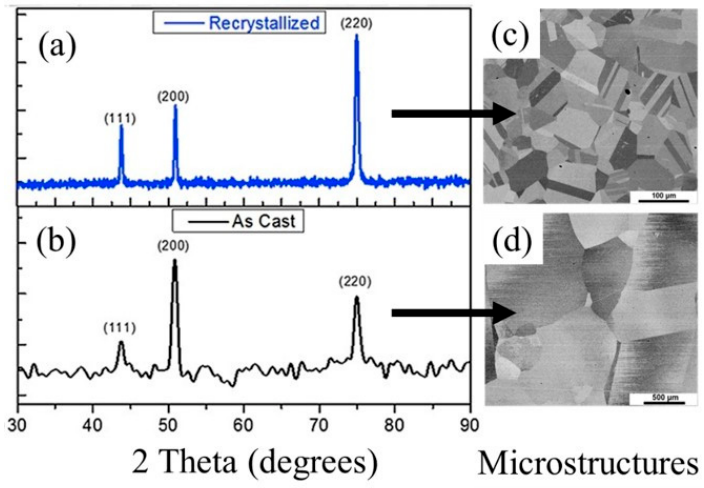
Figure 3. X-ray diffraction curves for Al 0.1 CoCrFeNi alloy in ( a ) recrystallized state heat-treated at 900 °C for 20 h, as compared to its ( b ) as-cast state. Corresponding back scattered electron scanning electron microscopy (SEM) microstructures of the alloys in ( c ) recrystallized and ( d ) as-cast states [31] (reprinted with permission from Elsevier).